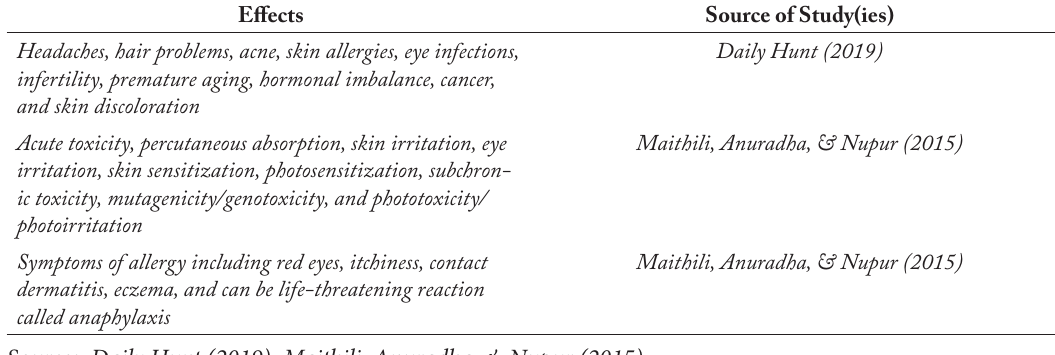
Table 4. Harmful Side Effects of